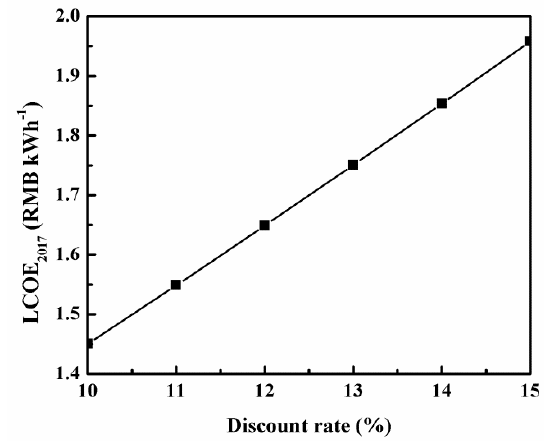
Figure 10. Influence of discount rate on the LCOE.